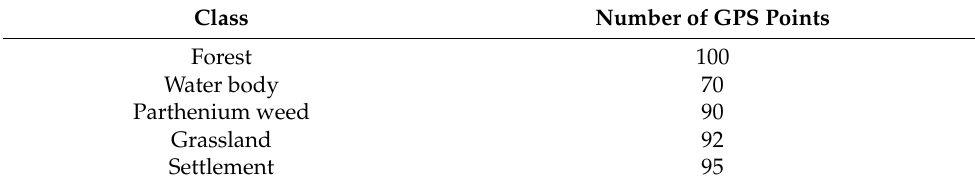
Table 1. Land use/cover classes and respective samples. Class